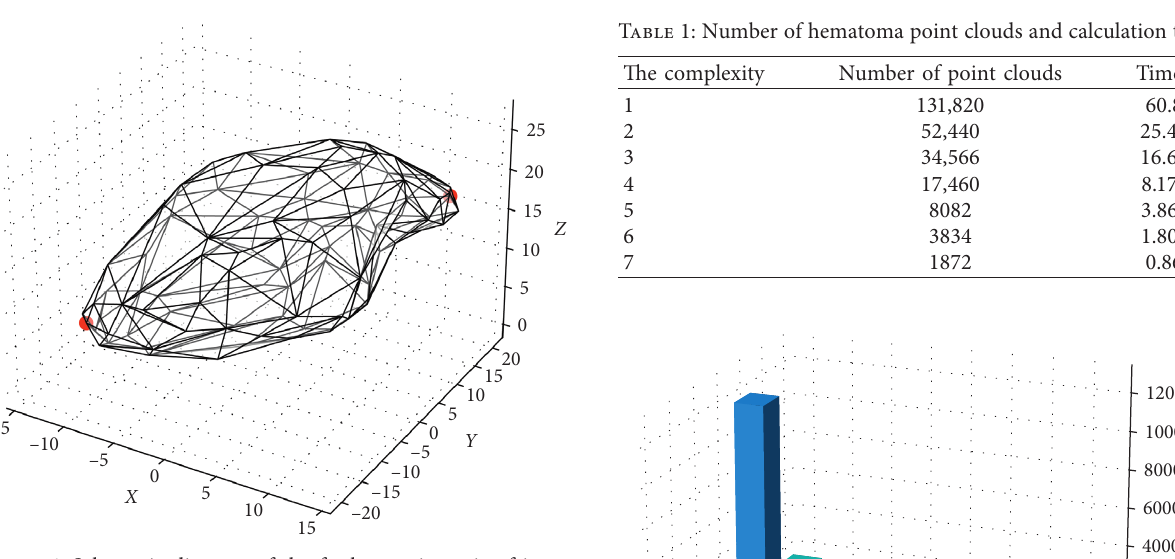
Figure 6: Schematic diagram of the farthest point pair of intra- cranial hematoma model.